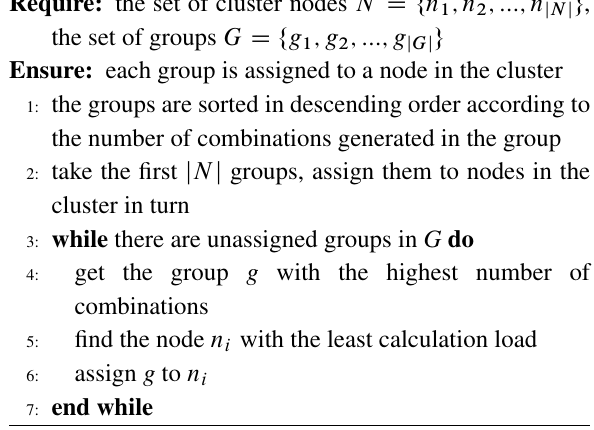
Algorithm 2 Group allocation